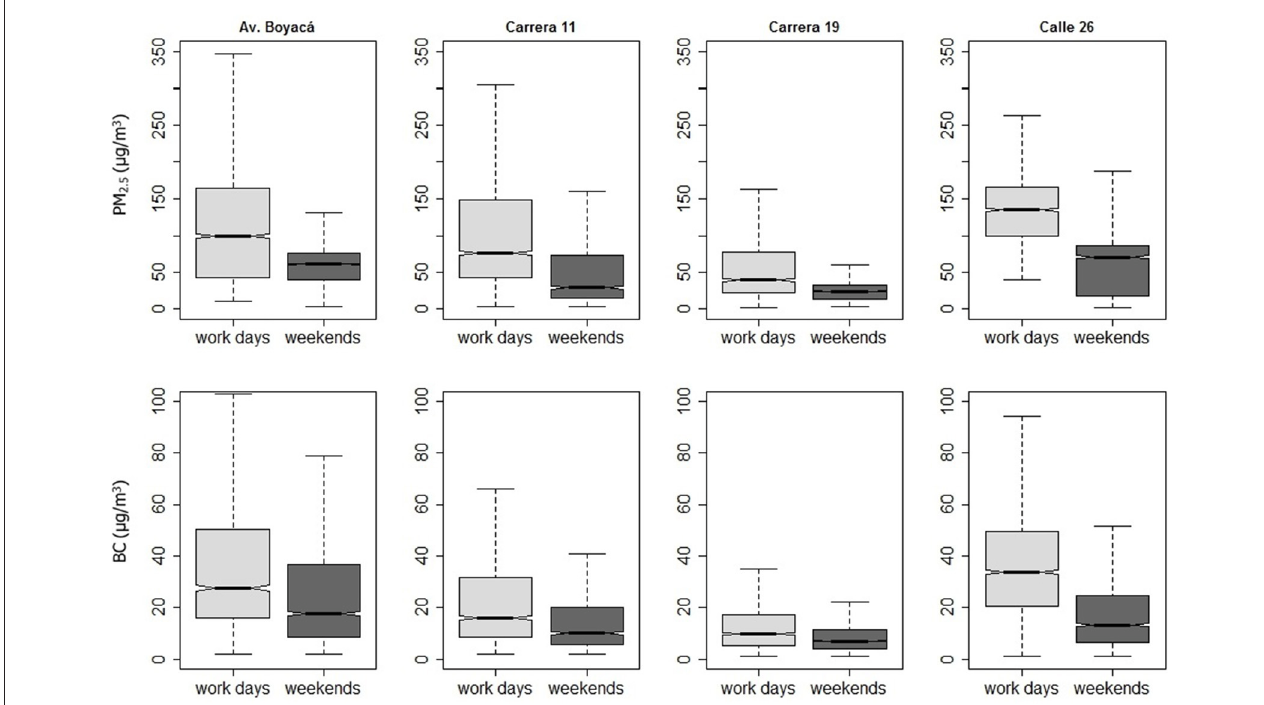
FIGURE 5 | Comparison between the distribution of concentrations of PM 2.5 and BC measured in workdays and weekends (all the bike-paths). The borders of the boxes indicate the first quartile (Q1), second (median), and third quartile (Q3) of the distribution, and the whiskers are located at 1.5 times the Q3–Q1 distance from the closest quartile.